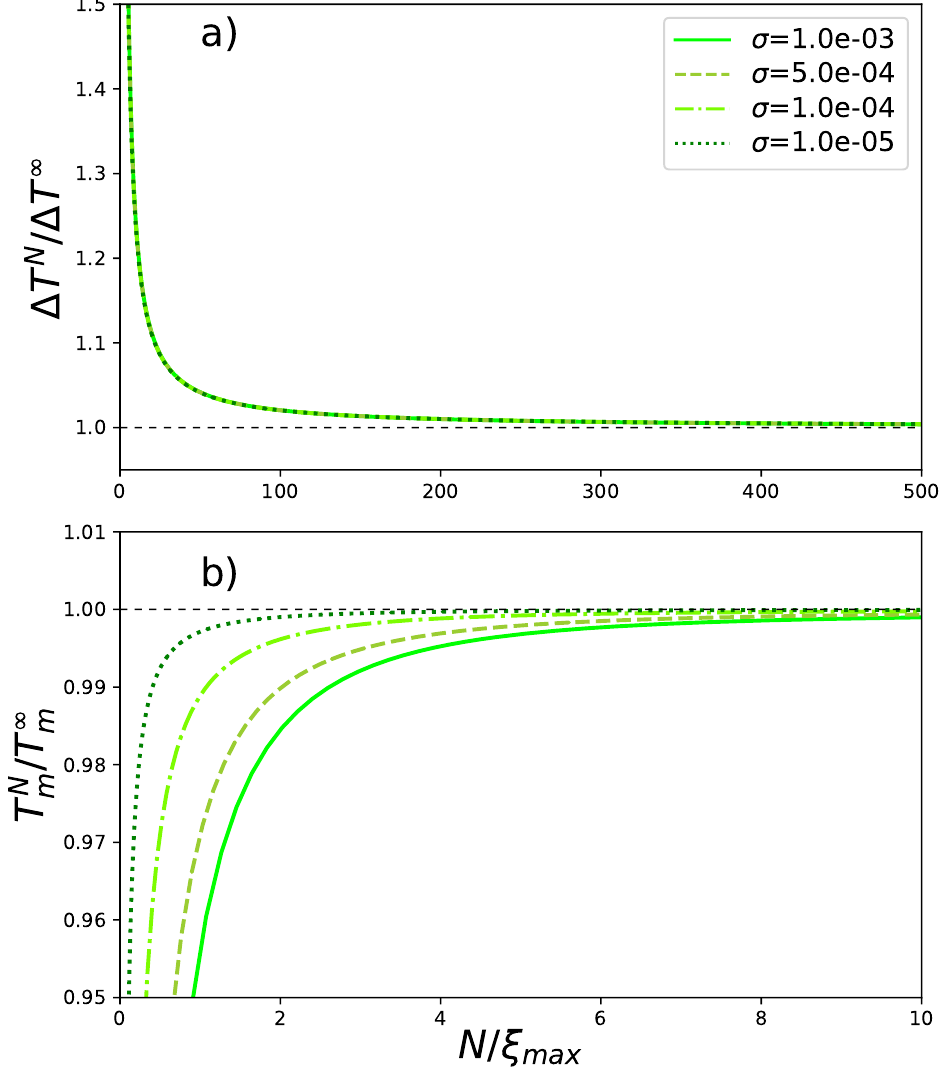
Figure 4. Transition interval and temperature in relative units: ( a ) ∆ T N / ∆ T ∞ and ( b ) T N m / T ∞ m over a range of reduced chain lengths N / ξ max at different values of cooperativity parameter σ (values shown in the